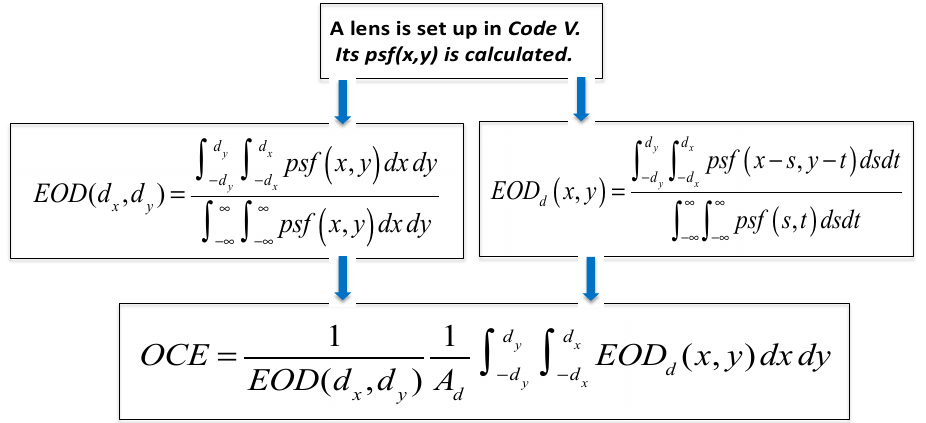
Figure 6. Block diagram to determine the EOD and OCE , using CodeV or some other lens design program to calculate the optical system psf(x,y).